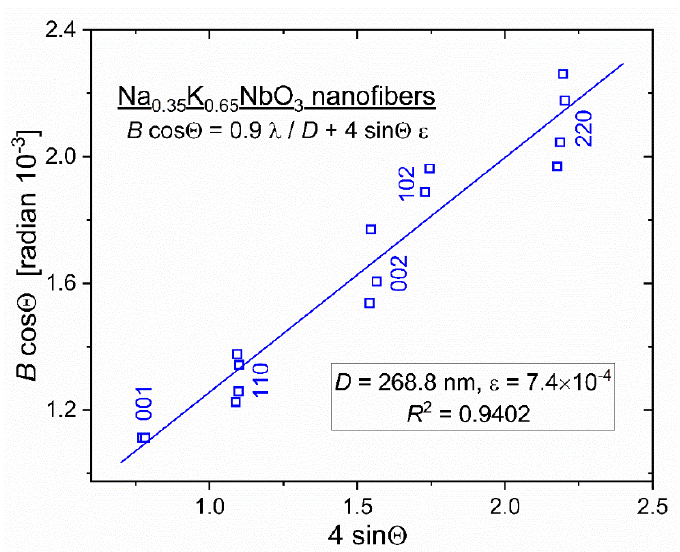
Figure 7. Williamson–Hall B · cos Θ vs. 4 · sin Θ plot for five XRD reflections. The straight line with the correlation coefficient R 2 = 0.9402 fits all the Bragg manifolds displayed in Figure 4. XRD-obtained values of the averaged crystal size D and the microstrain ε conform, re- spectively, to the high-resolution TEM image in Figure 2 and to as small as 0.04%